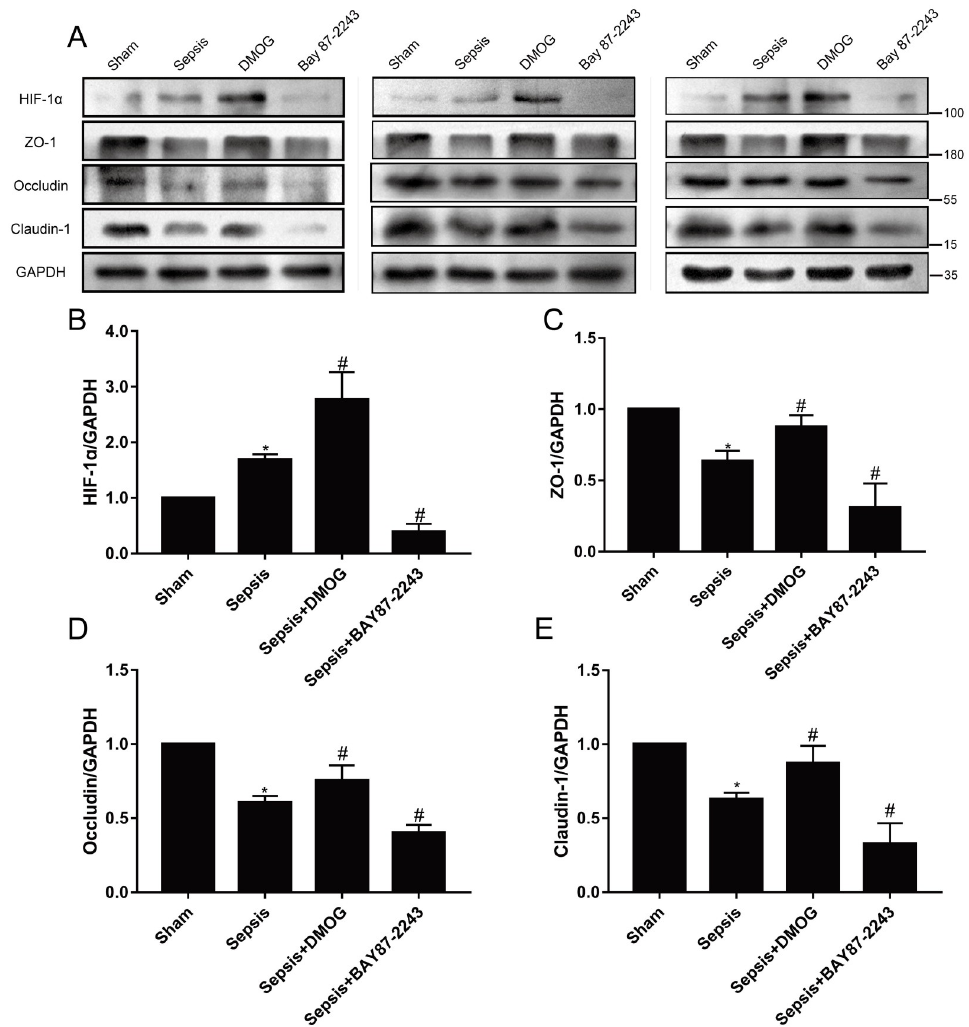
Fig 4. Effects of an HIF-1 α activation/inhibition on the protein expression of HIF-1 α (B) and TJ proteins (C-E) in the intestinal mucosa of rats ( n = 6 except sepsis + BAY 87–2243 with n = 5). Data are expressed as the mean (SD). A. Bands showing protein expression (three animals). B-E. Protein expression of HIF-1 α , ZO-1, Occludin, and Claudin-1. � P < 0.05 compared with the sham group; # P < 0.05 compared with the sepsis